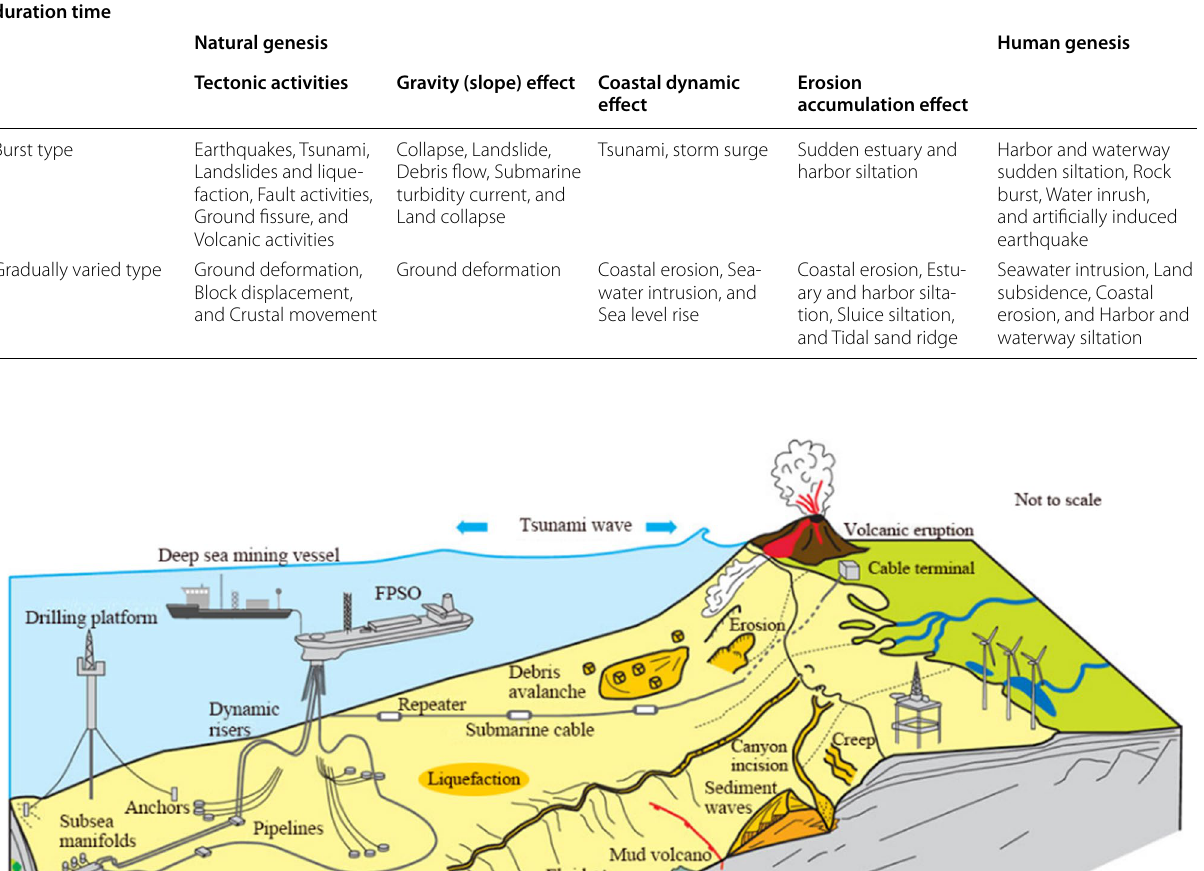
Table 1 The causes of marine geological disasters (modified from Camargo et al. 2019; Ye et al. 2017b; Cuomo 2020) Occurrence and duration time